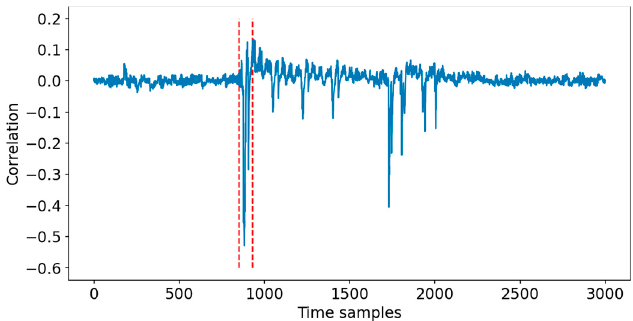
Figure 7. CPA results correspond to the correct key.